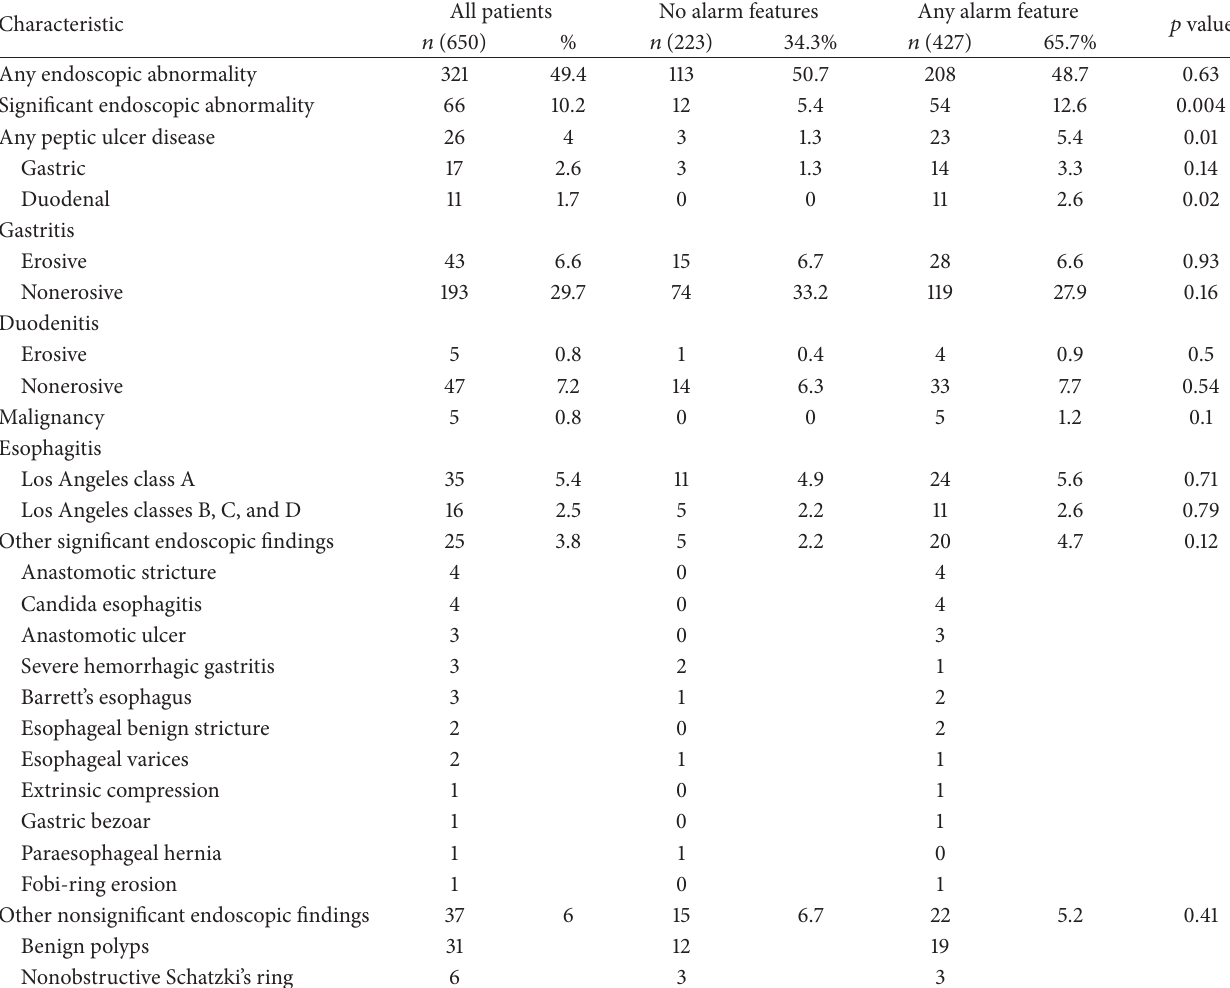
Table 2: Endoscopic findings in outpatients with dyspepsia, stratified by alarm features; Grady Memorial Hospital, Atlanta, Georgia, June 1, 2011–July 1,